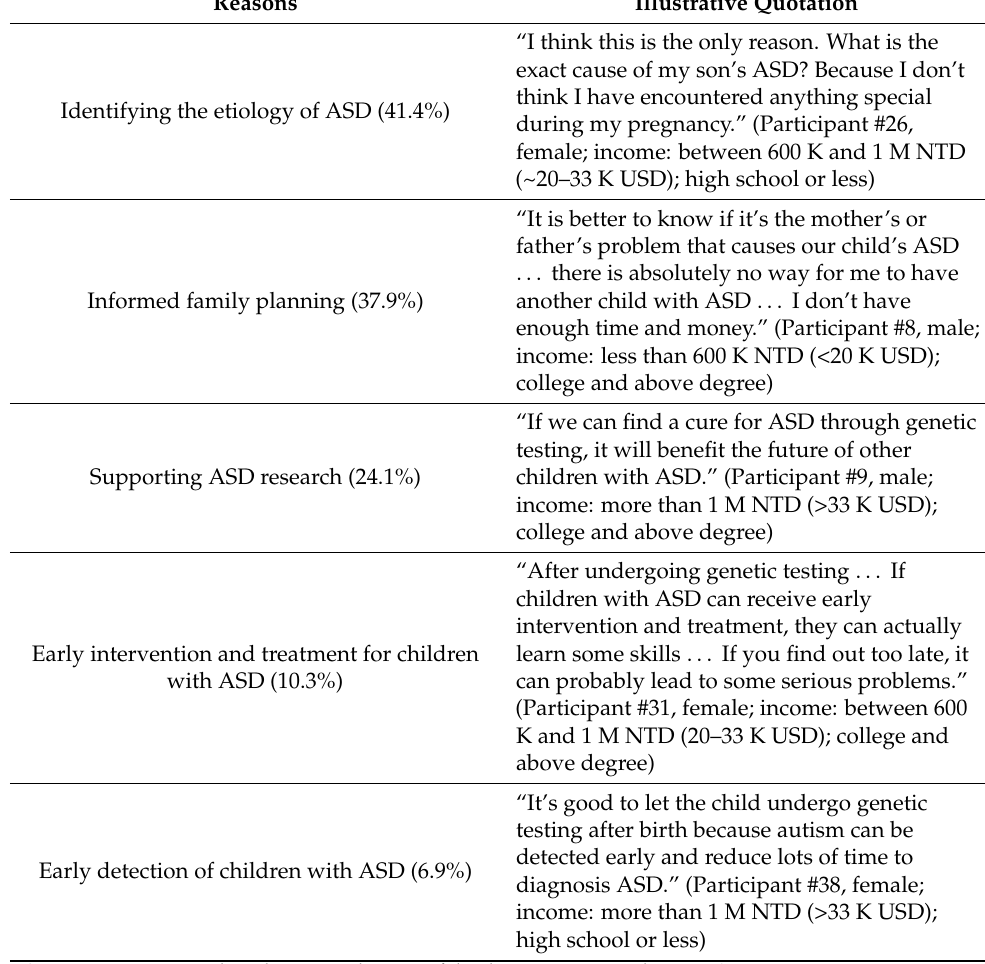
Table 1. Reasons for pursuing ASD genetic testing among parents of children with